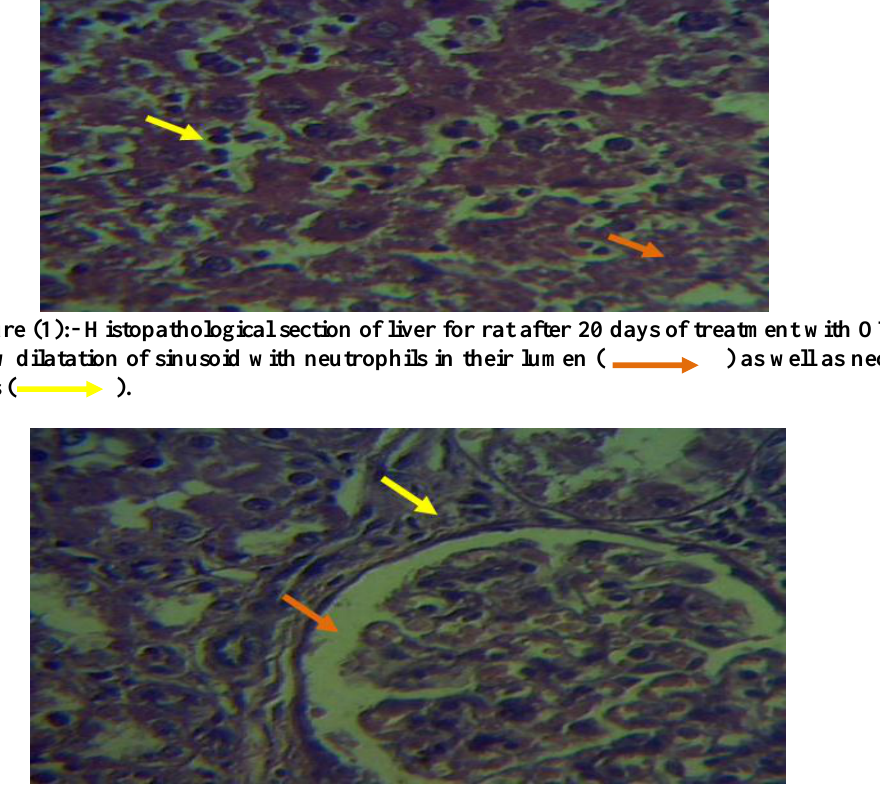
Figure (2):- Histopathological section of kidney for rat after 20 days of treatment with OTA at dose 70µg/kg , shows thickness of Bowman capsule(